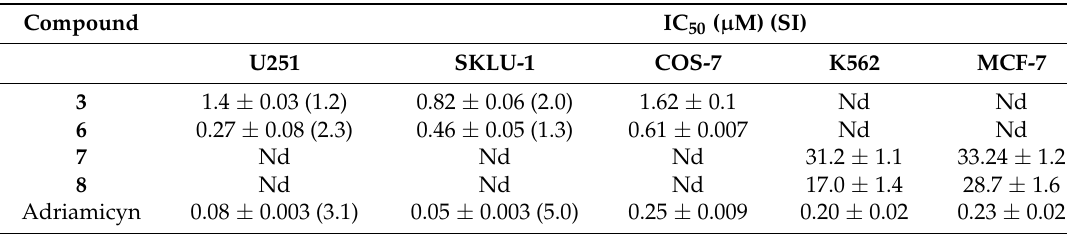
Table 7. IC 50 ( µ M) values of antiproliferative activity for compounds 3 , 6 , 7 , and 8 . Compound IC 50 ( µ M) (SI) U251 SKLU-1